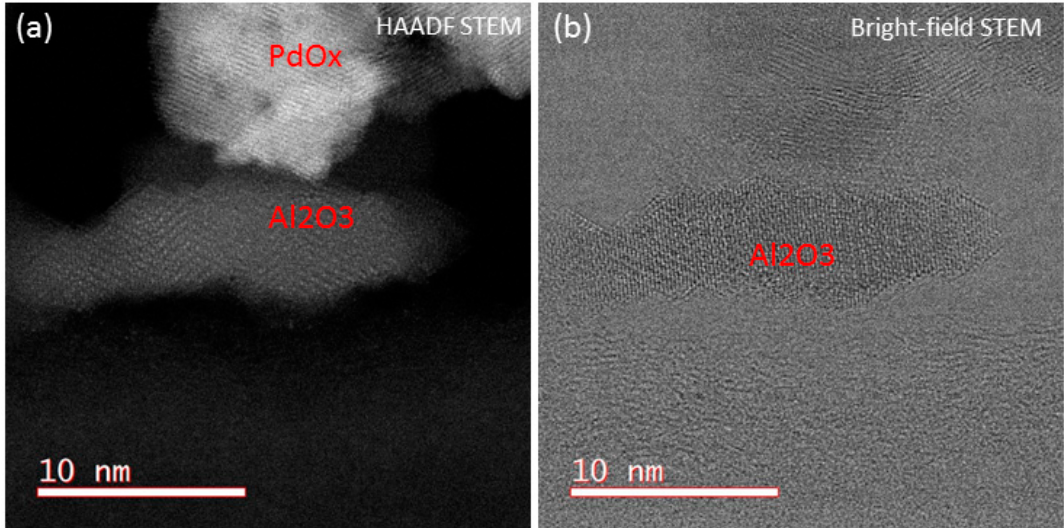
Figure 5. ( a ) z-contrast HAADF STEM image of PdO x and γ -Al 2 O 3 ; ( b ) phase-contrast Bright-field STEM image of PdO x and γ -Al 2 O 3 . Both images are from the same area; the γ -Al 2 O 3 particles are crystalline, not in amorphous phase.